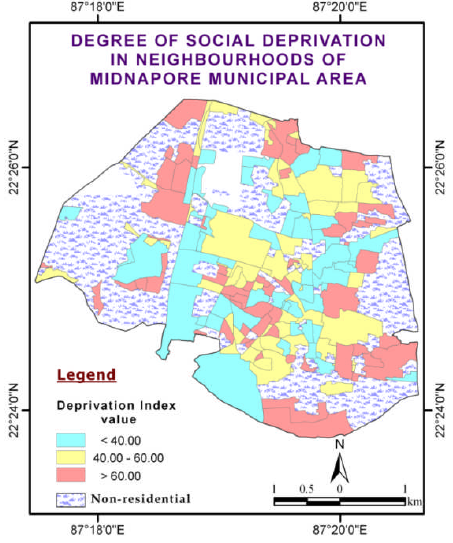
Figure 7. Neighbourhoods with degree of social